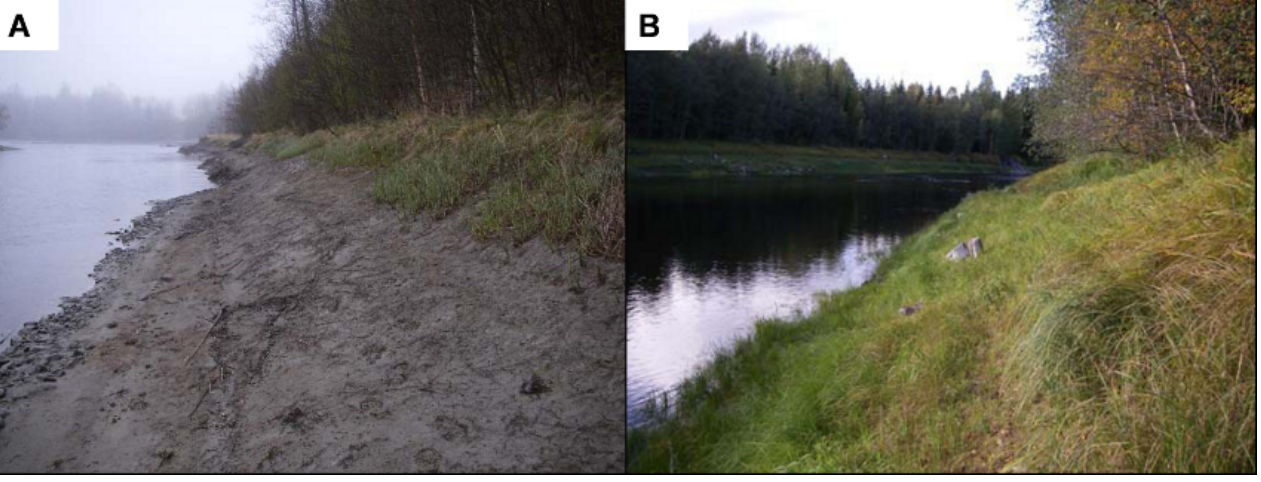
Fig. 2 . Recolonization of vegetation on the soils of the former reservoir upstream of the Kuba dam occurred within a few months after dam removal. (A) The former reservoir in May 2007, (B) the same site in September